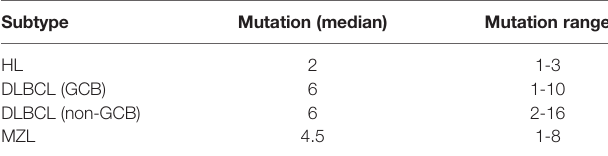
TABLE 2 | ctDNA mutation in patients of different pathological subtypes. Subtype